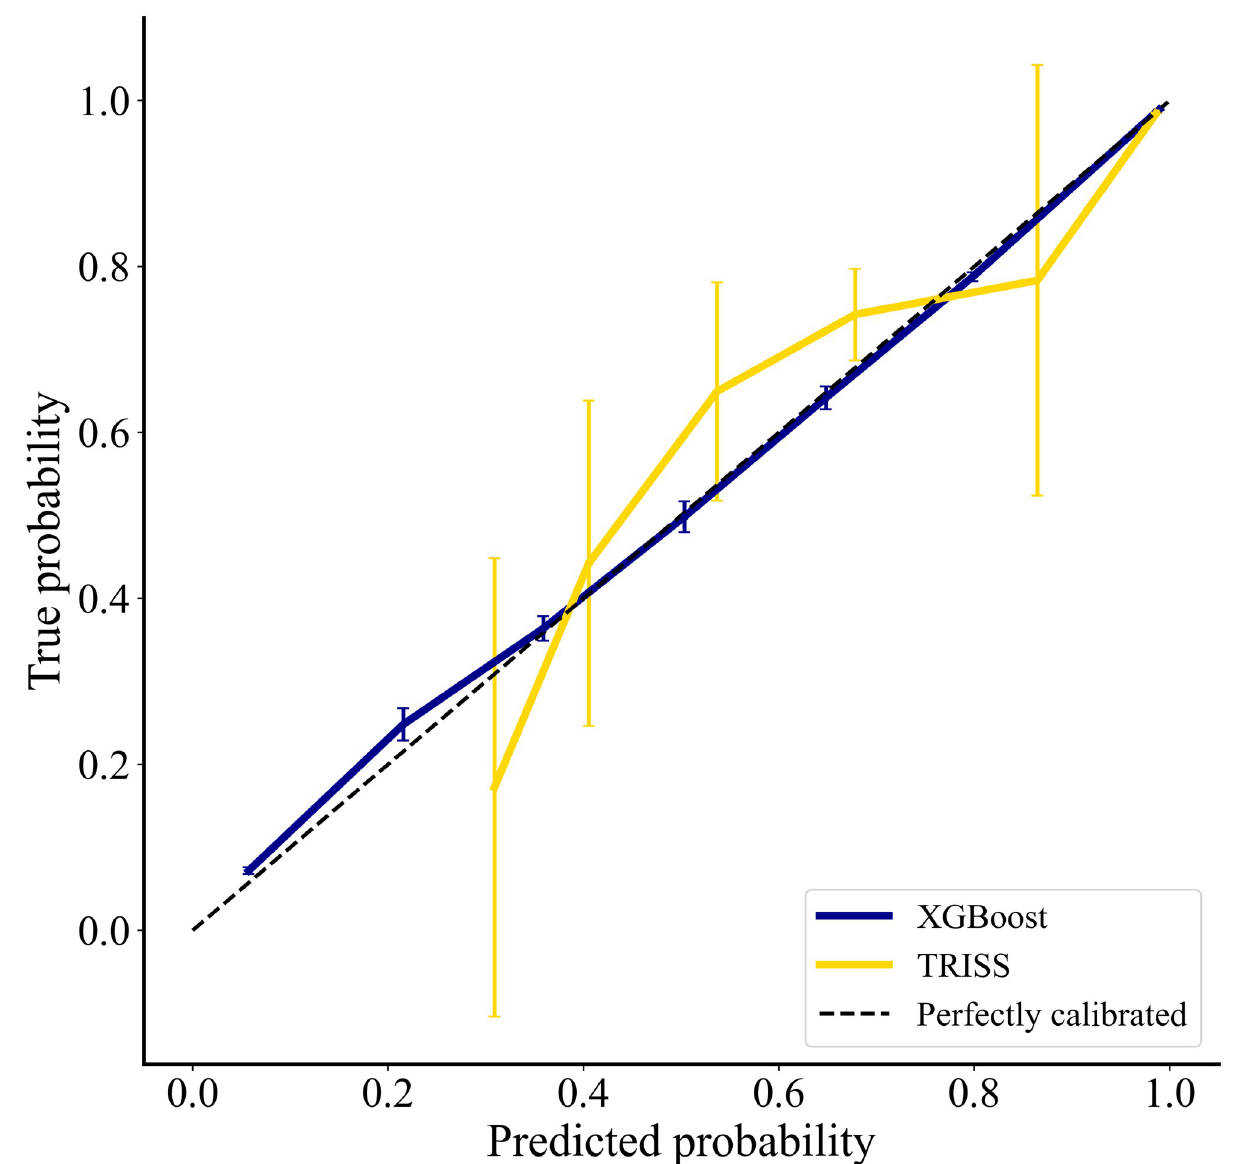
Fig 3. Calibration curves comparing XGBoost with